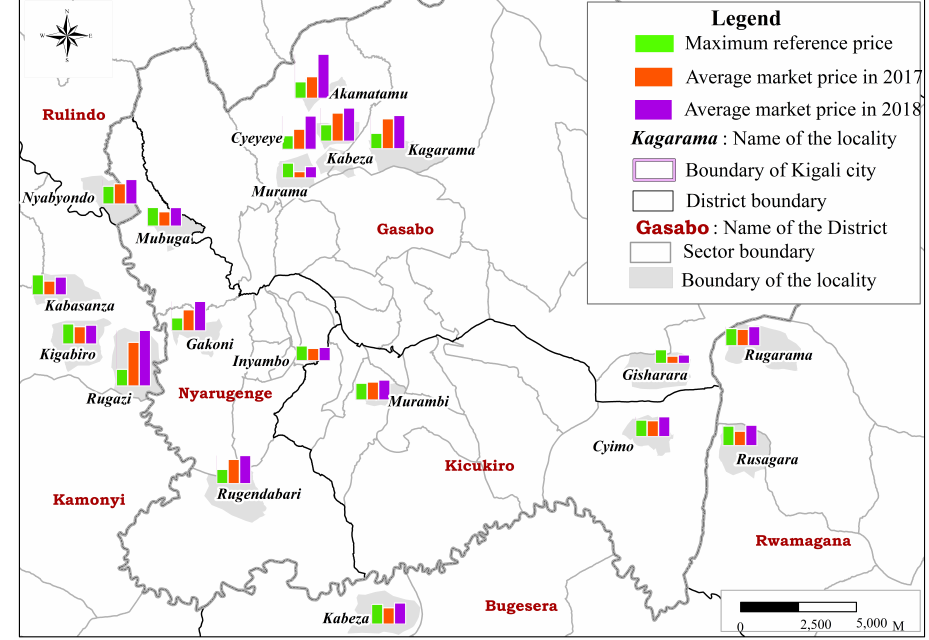
Figure 5. Comparison between maximum reference price for expropriation and the market. Figure 4. Figure5.This is a figure, Schemes follow the same formatting. If there are multiple panels, they should be listed as: ( a ) Description of what is contained in the first panel. ( b ) Description of what Data sources: Household surveys; Land transaction reports and compensation reference prices list is contained in the second panel. Figures should be placed in the main text near to the first time they 2017–2018 are cited. A caption on a single line should be centered.